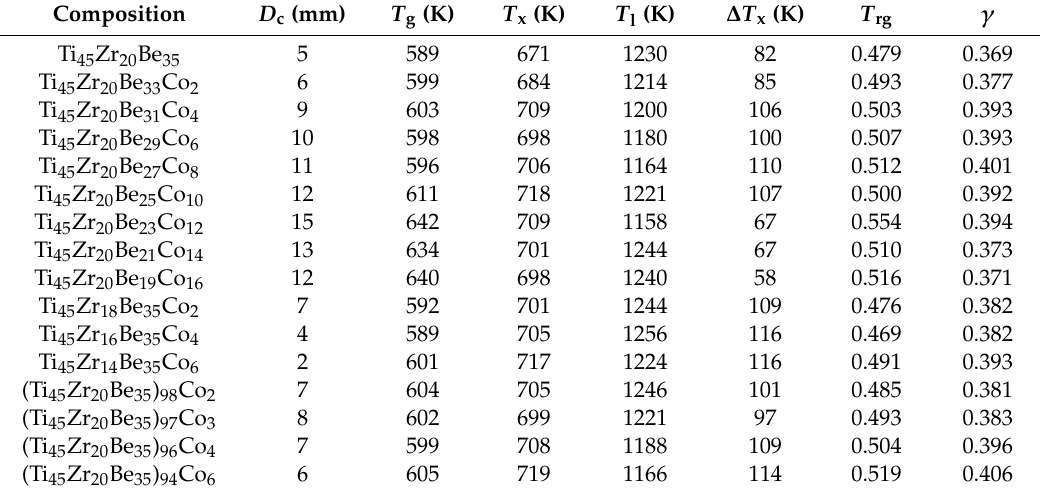
Figure 4. DSC curves of ( a ) Ti 45 Zr 20 Be 35 − x Co x ( x = 0, 2, 4, 6, 8, 10, 12, 14, and 16), ( b ) Ti 45 Zr 20 − x Be 35 Co x ( x = 0, 2, 4, and 6), and ( c ) (Ti 45 Zr 20 Be 35 ) 100 − x Co x ( x = 0, 2, 3, 4, and 6) samples with different heating rates. Table 1. Thermal parameters of Ti-Zr-Be-Co alloys (heating rate: 20 K / min, accuracy: ± 1